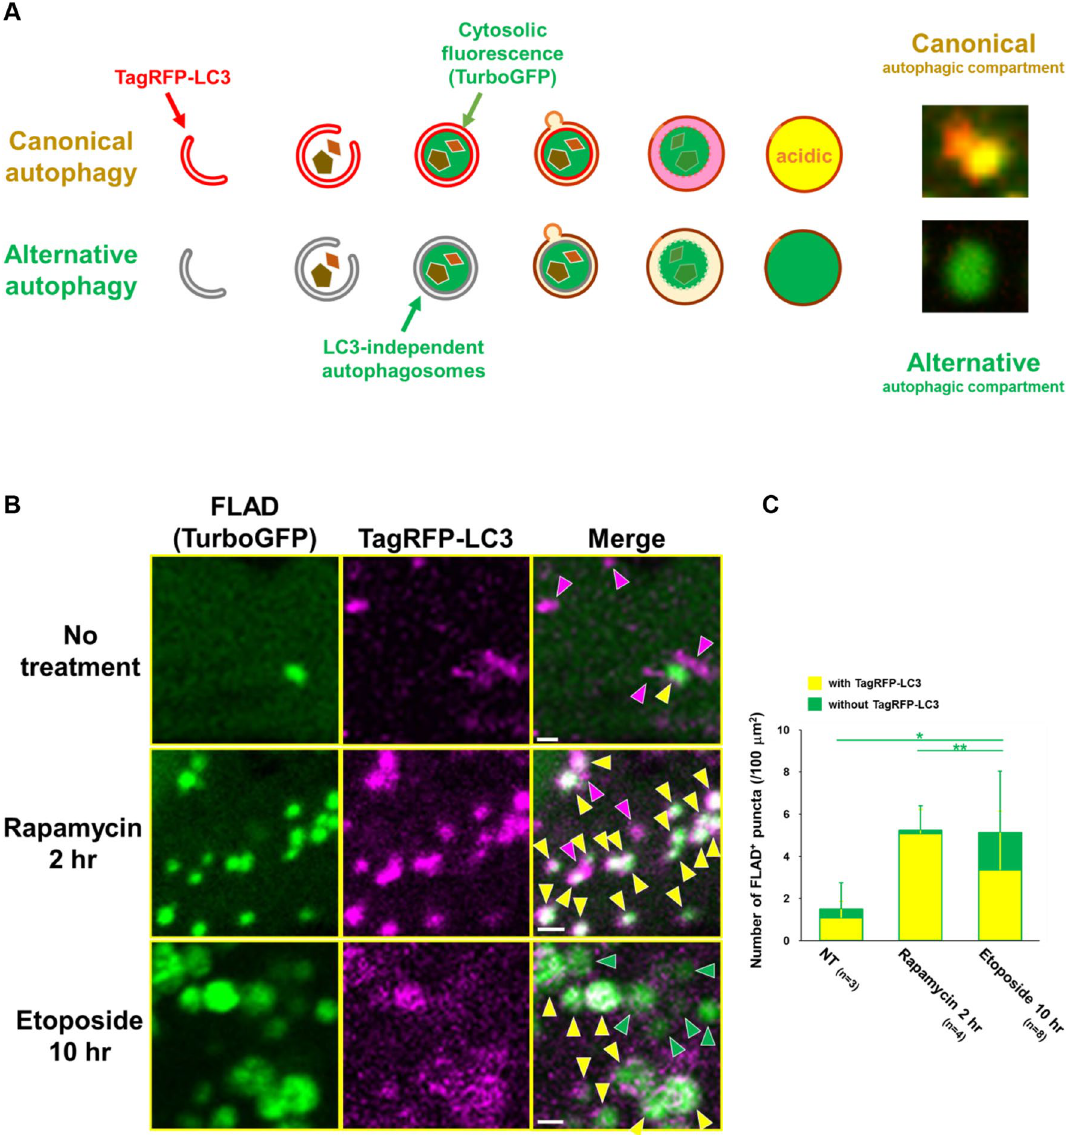
Figure 4. Simultaneous detection of canonical and alternative autophagy using FLAD and TagRFP-LC3. (A) Schematic model of the assay. Closed compartments from canonical autophagy can be detected as yellow puncta because of the signals of TagRFP-LC3 (red) and FLAD (green), whereas those from alternative autophagy can be detected as green puncta because of the signal of FLAD (green). (B, C) Wild-type MEFs transiently coexpressing TagRFP-LC3 and TurboGFP were treated with etoposide (10 µ M) for 10 h or rapamycin (0.5 µ M) for 2 h, and then the FLAD assay was performed. In ( B ), representative images are shown. Green puncta and white puncta indicate closed compartments from alternative autophagy and canonical autophagy, respectively. Magenta puncta indicate open structures (phagophores) from canonical autophagy. In (C) , the number of FLAD + puncta with tagRFP-LC3 (yellow) and without tagRFP-LC3 (green) in the non-bleached area was quantified. The total number of images used for analysis is given as the n . Data are shown as the mean ± S.D. * p < 0.05, ** p < 0.01 (one- way ANOVA followed by the Tukey post hoc